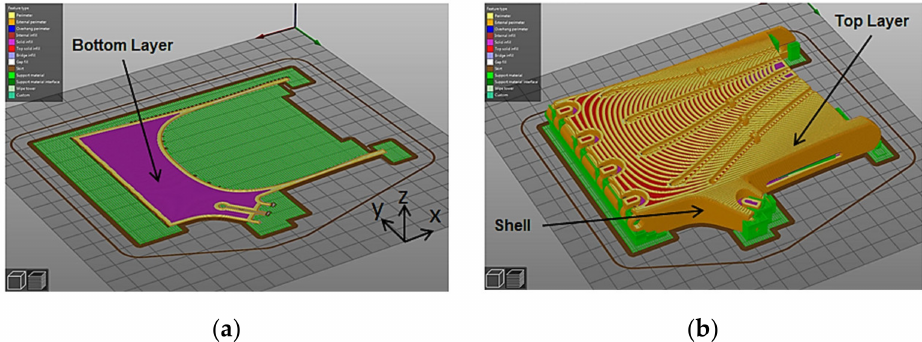
Figure 4. Some fixed printing parameters: ( a ) Bottom Layer-;( b ) Top Layer and Shell.